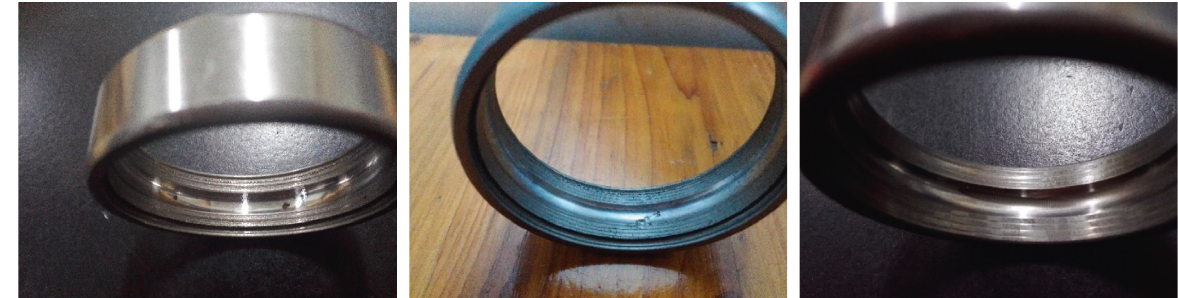
Figure 1: (a) Outer ring pitting; (b) outer ring crack; (c) outer ring current damage.